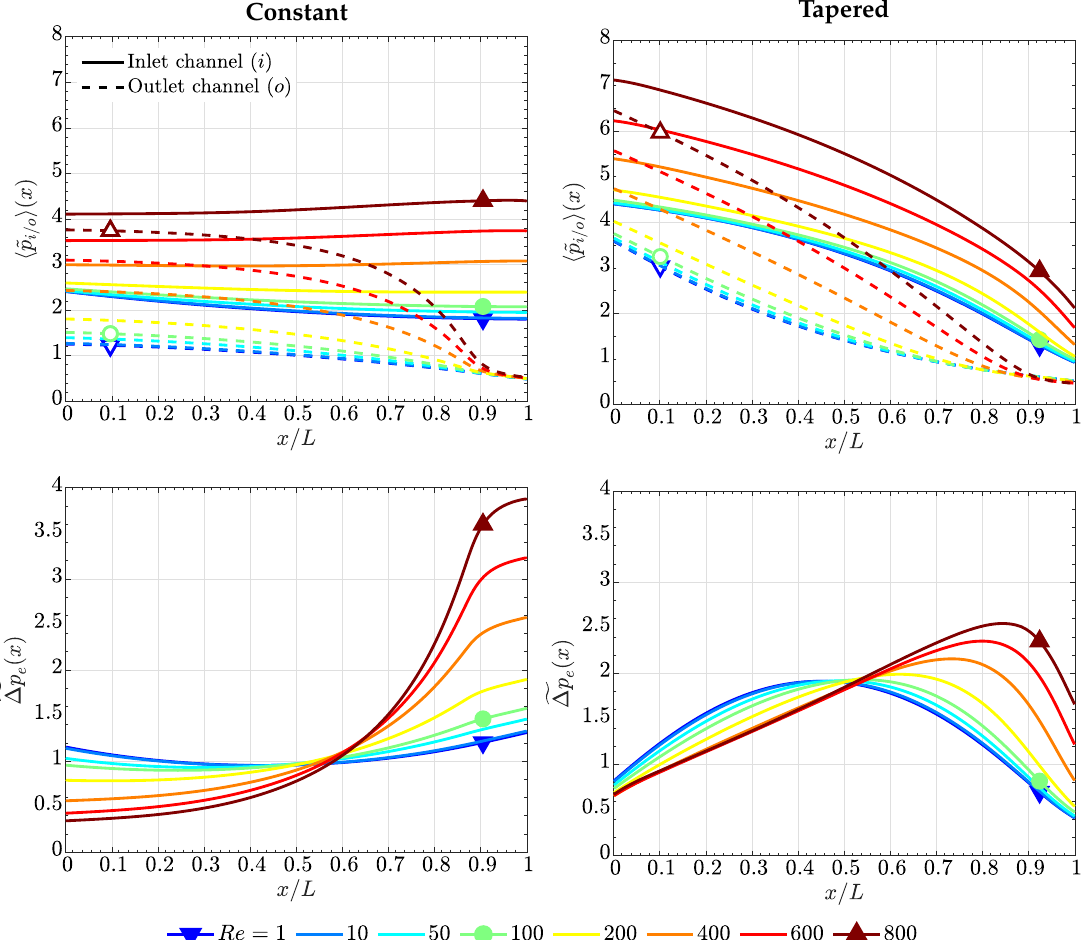
Figure 3. Variation of ( top ) the y -averaged pressure in the inlet and outlet channels, (cid:104) ˜ p i / o (cid:105) ( x ) , and ( down ) the pressure drop across the electrode, (cid:102) ∆ p , as a function of the along-the-channel coordinate, e x / L , for Re = 1–800, corresponding to ( left ) the constant cross-section and ( right ) the tapered flow fields. Electrode permeability, K e = 10 − 10 m 2 ( γ ∼ 1 ) , and Λ =